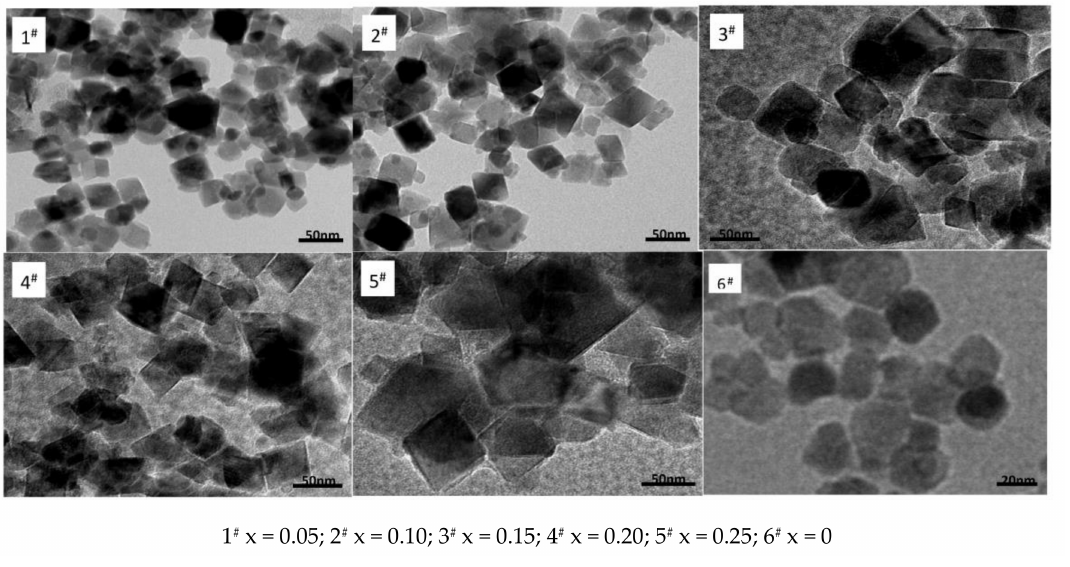
Figure 2. Transmission electron micrograph of samples prepared with different Co 2+ content.